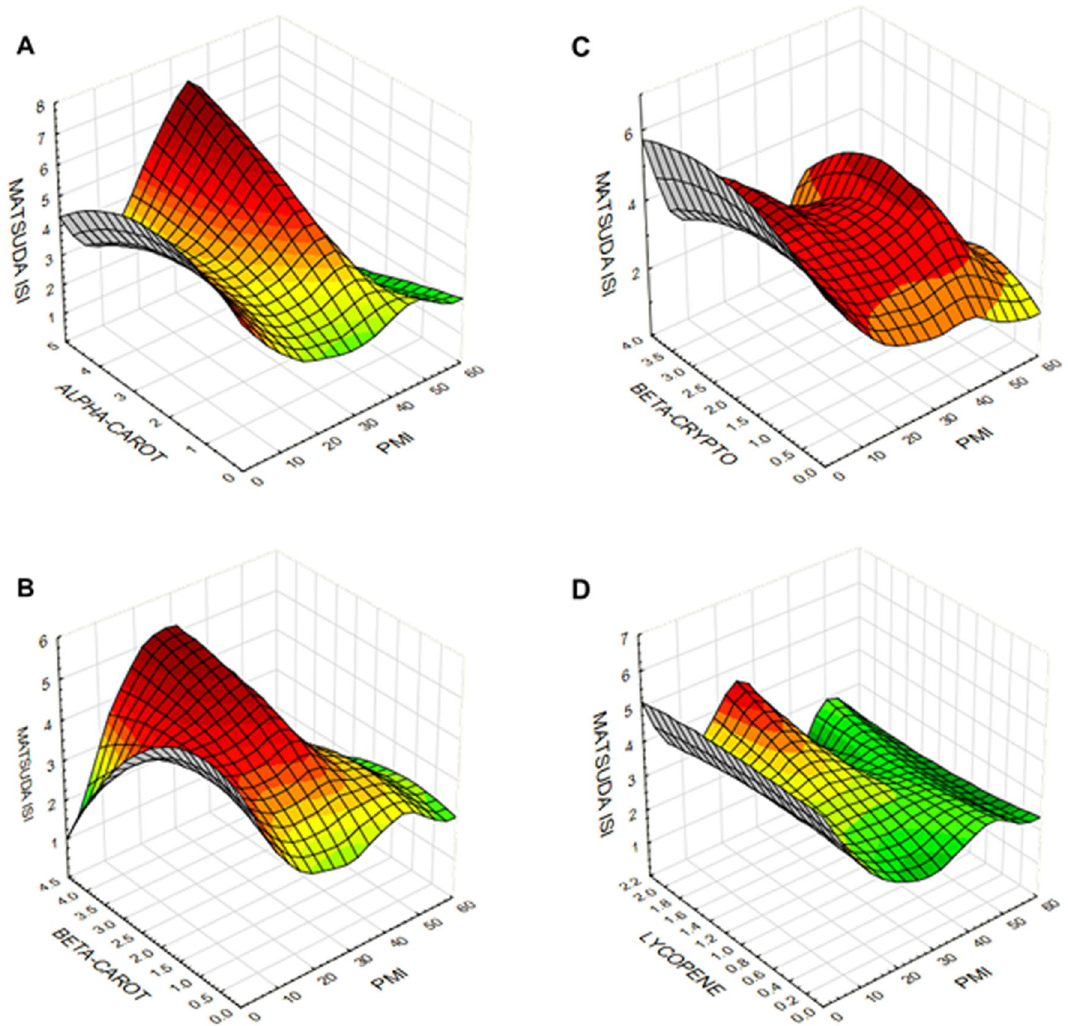
Figure 2. Response surface contour plots showing the relationship of α-carotene ( A ), β-carotene ( B ), β-cryptoxanthin ( C ), and lycopene ( D ) and PMI with Matsuda ISI. The contour plots are colored to aid in better visualization of the